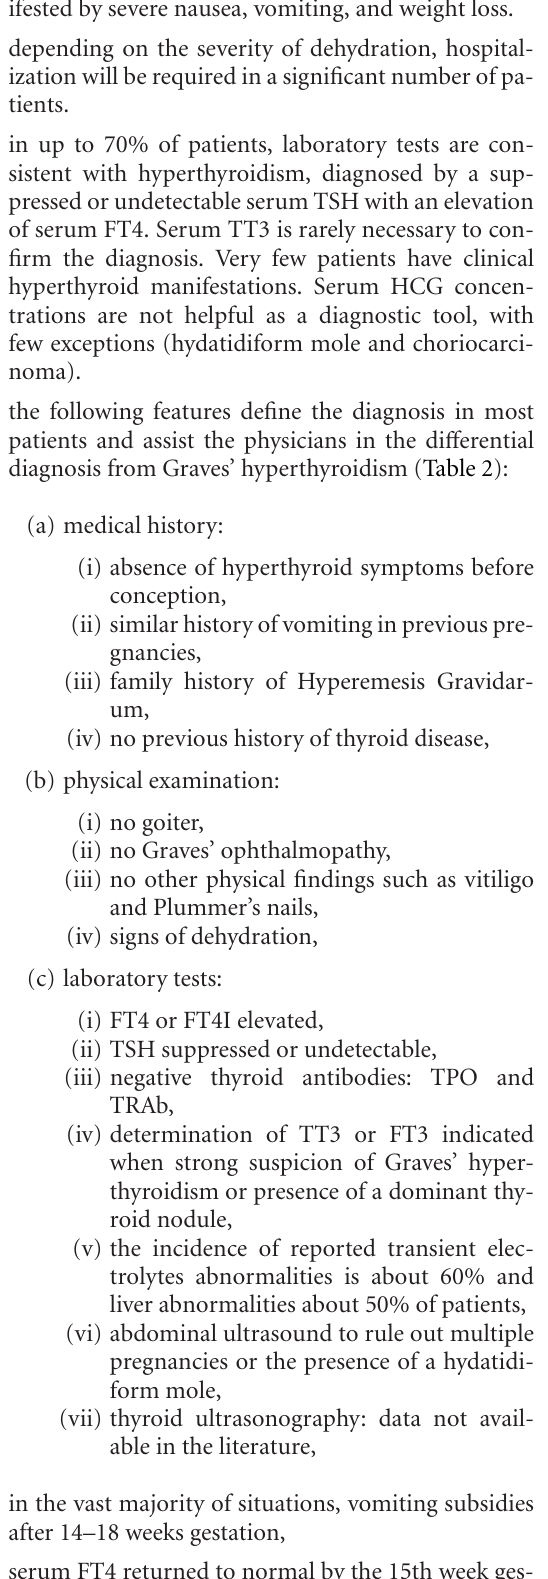
Table 2: Hyperthyroidism and pregnancy clinical clues in the dif- ferential